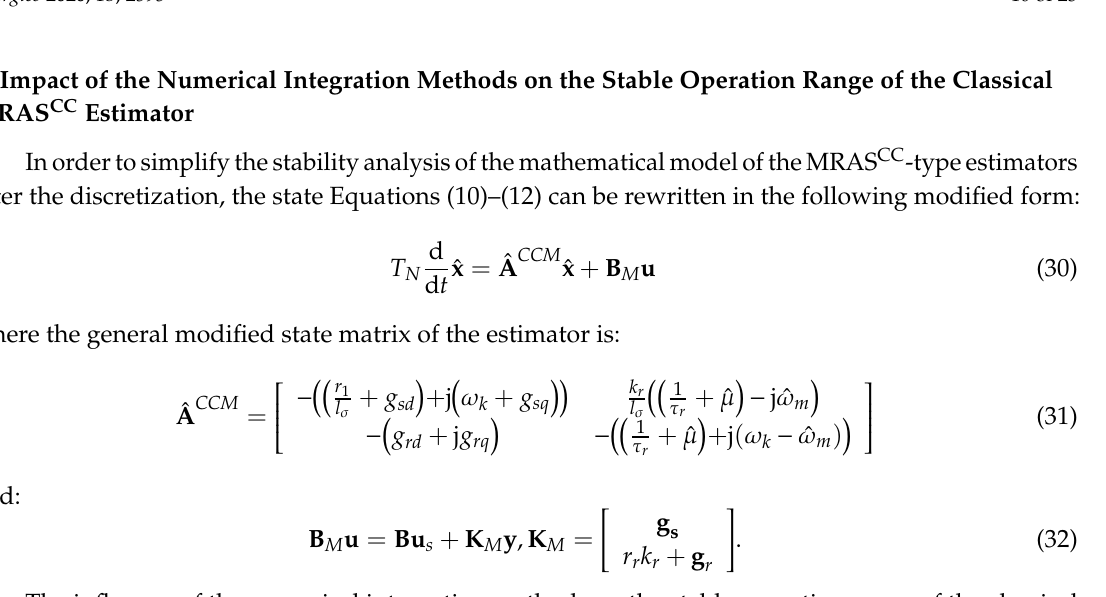
Figure 4. Photograph of the experimental set-up.